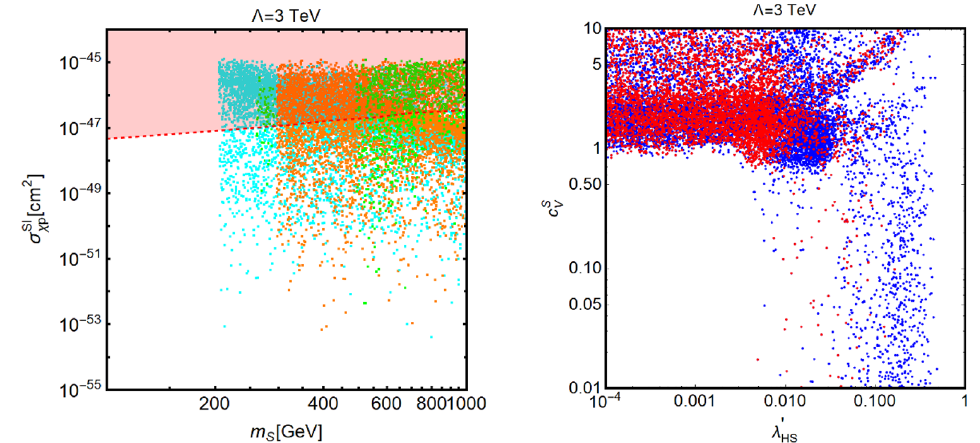
Figure 10 . Left Panel: model points in the m S (cid:0) (cid:27) SI all current experimental constraints but being potentially testable at colliders in the near future according to the criteria given in the main text. The di(cid:11)erent colors indicate the processes which can be used to probe the corresponding points, namely pp ! S ! V V (cyan), pp ! S ! hh (green) and pp ! S ! (cid:13)(cid:13) (orange). The regions marked in red will be excluded in the case of no signal at XENONnT. Right panel : same model points in the (cid:21) 0 feature DM scattering cross-sections above the projected limit from XENONnT while red ones will also pass this upcoming